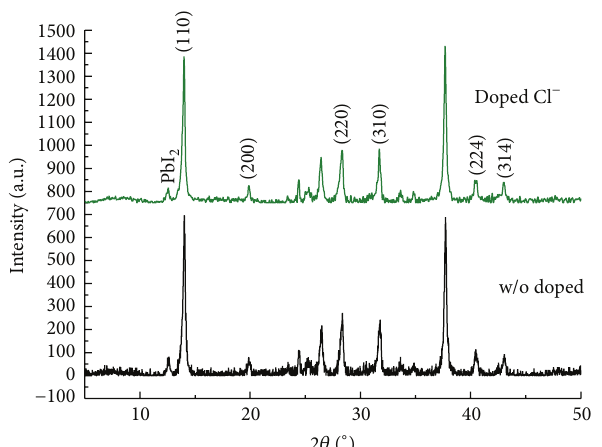
Figure 4: XRD patterns of perovskite films fabricated with different approaches (from top to bottom: doped Cl − and w/o doped).